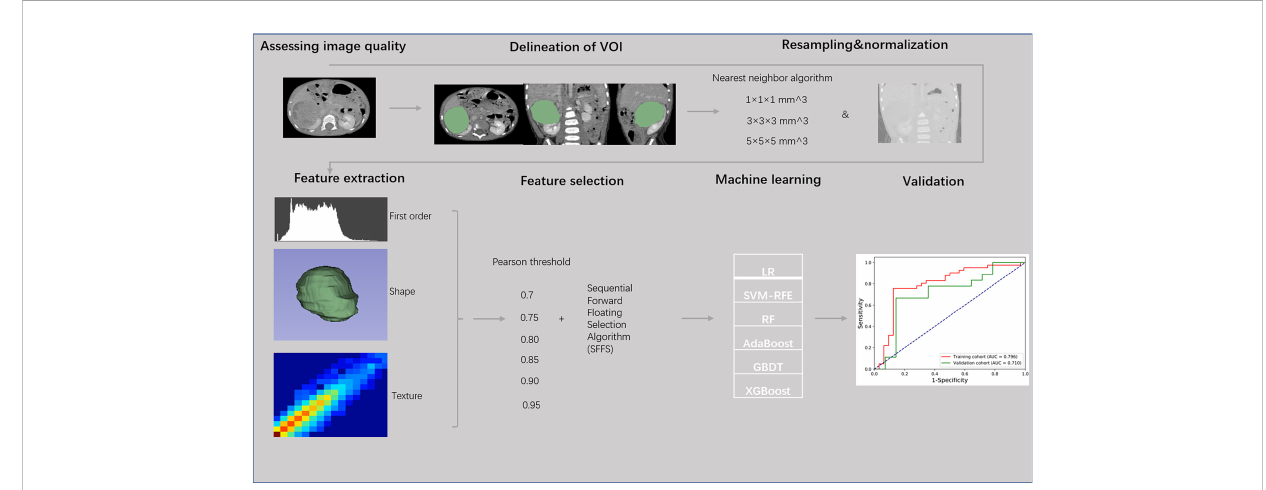
FIGURE 2 Flow chart of radiomics analysis of localized